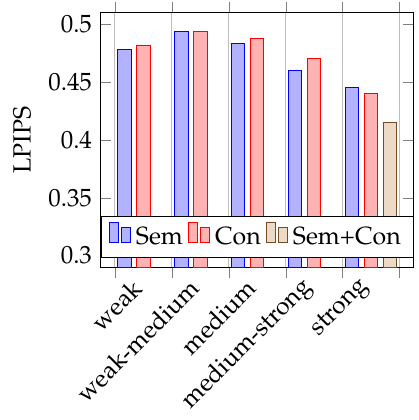
Figure 5. Mean LPIPS on real